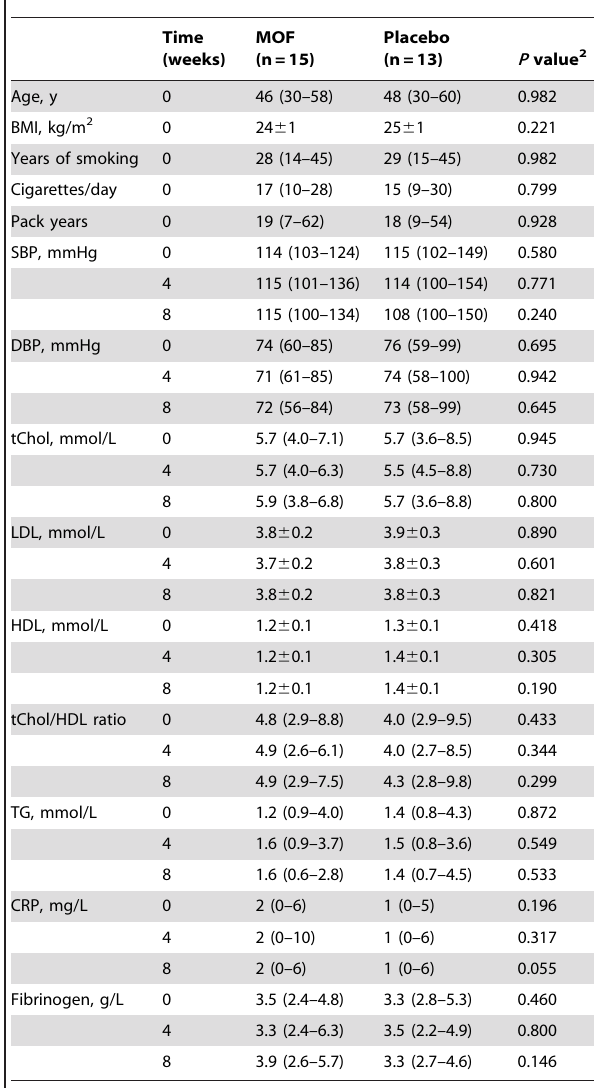
Table 2. Clinical characteristics of the study population 1